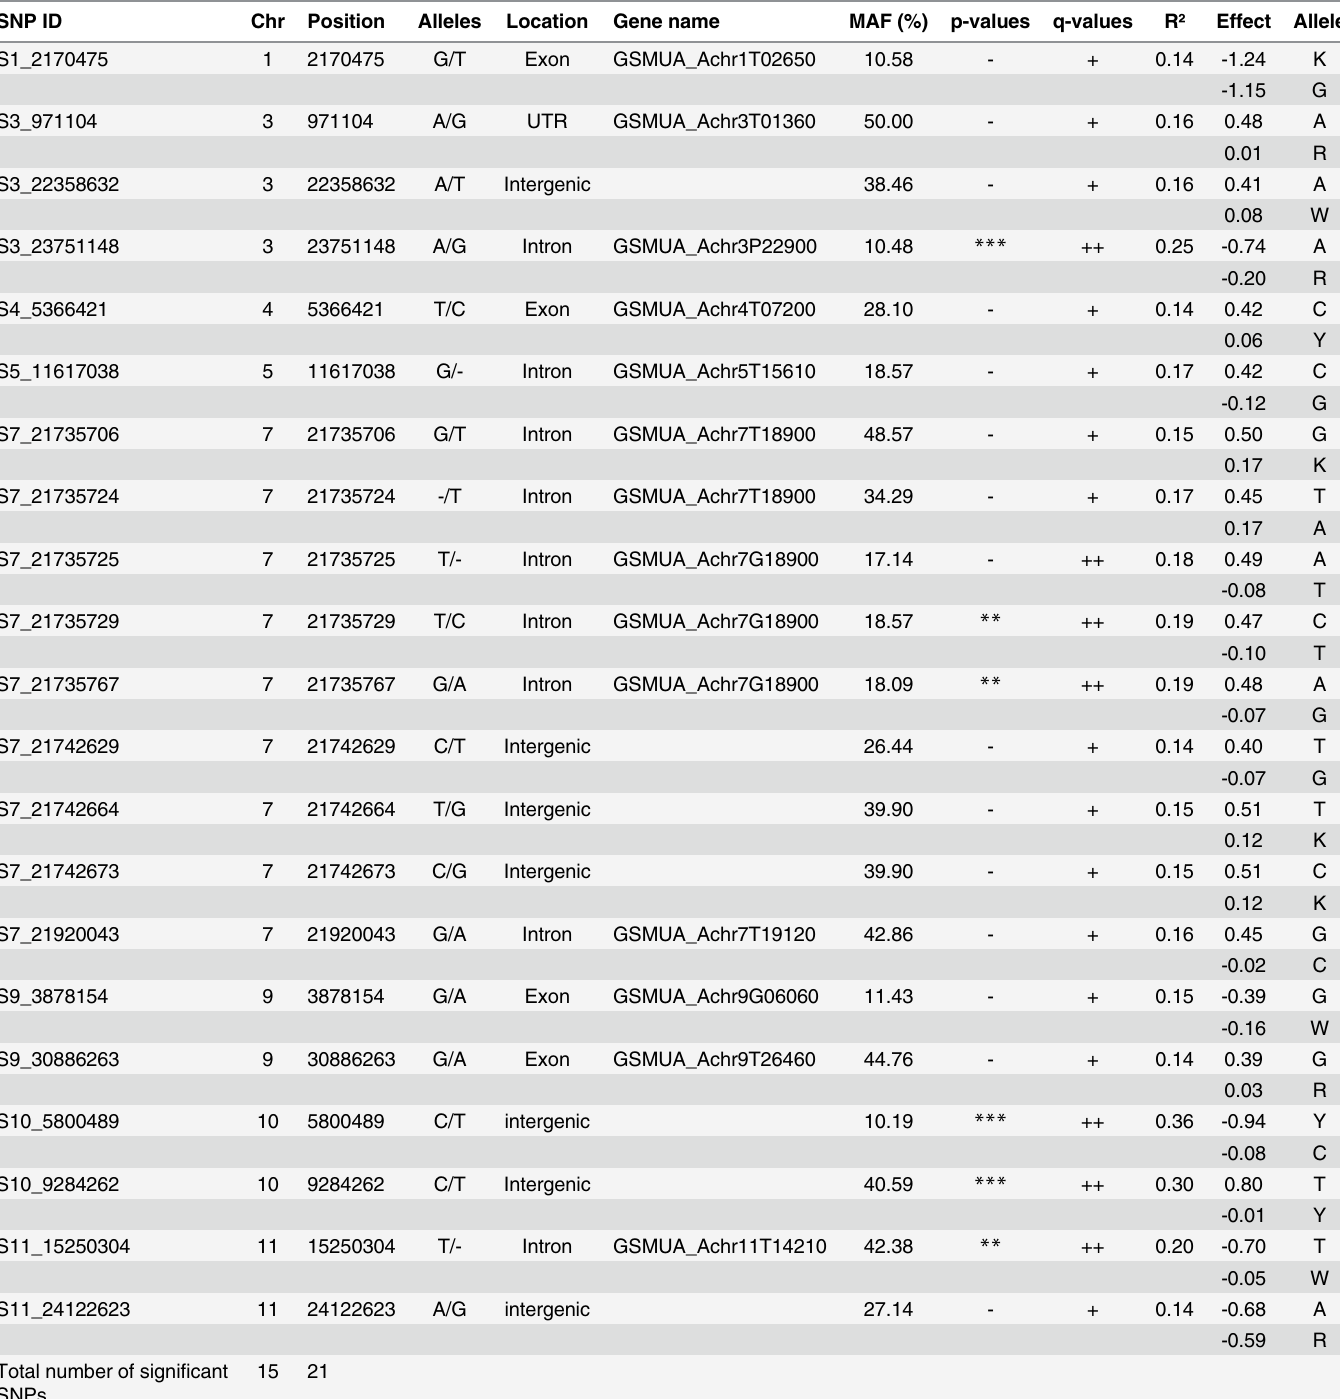
Table 3. SNPs statistically associated to the seedless phenotype when analysing the panel with the MLM K + Q (K = 4) and the corresponding ranges of p- and q-values obtained. SNPs in bold are those commonly detected when analyzing the subset. R² is the proportion of phenotypic variance explained by the